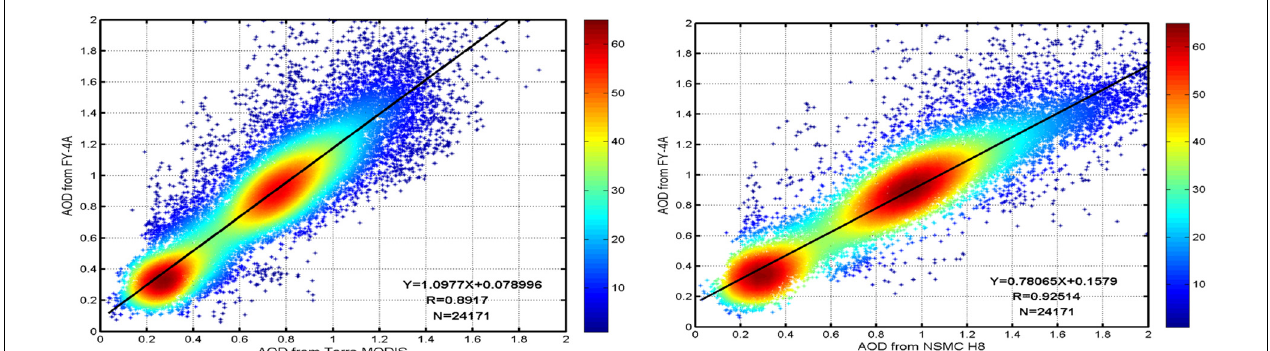
FIGURE 2 | Comparisons of FY-4A/AGRI AOD and (left) Terra/MODIS AOD, and (right) Himawari/AHI AOD.